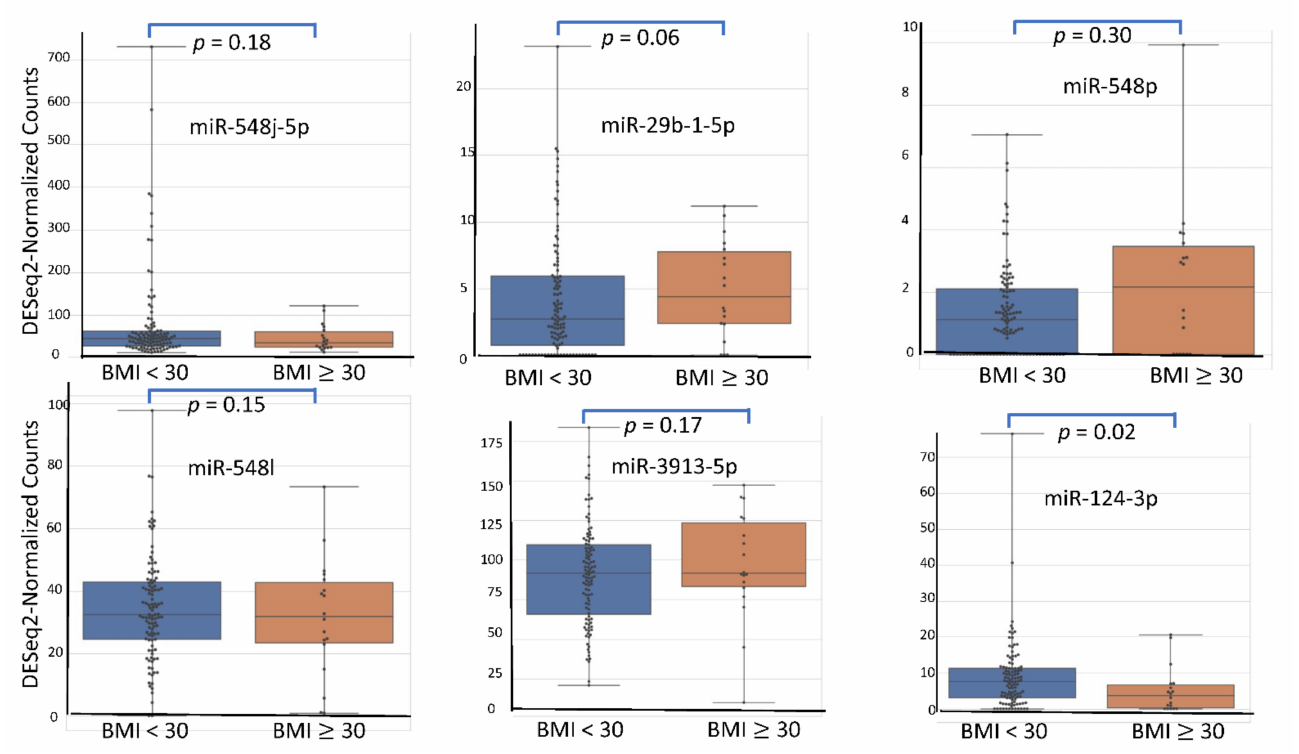
Figure 2. miRNA expression level according to BMI.